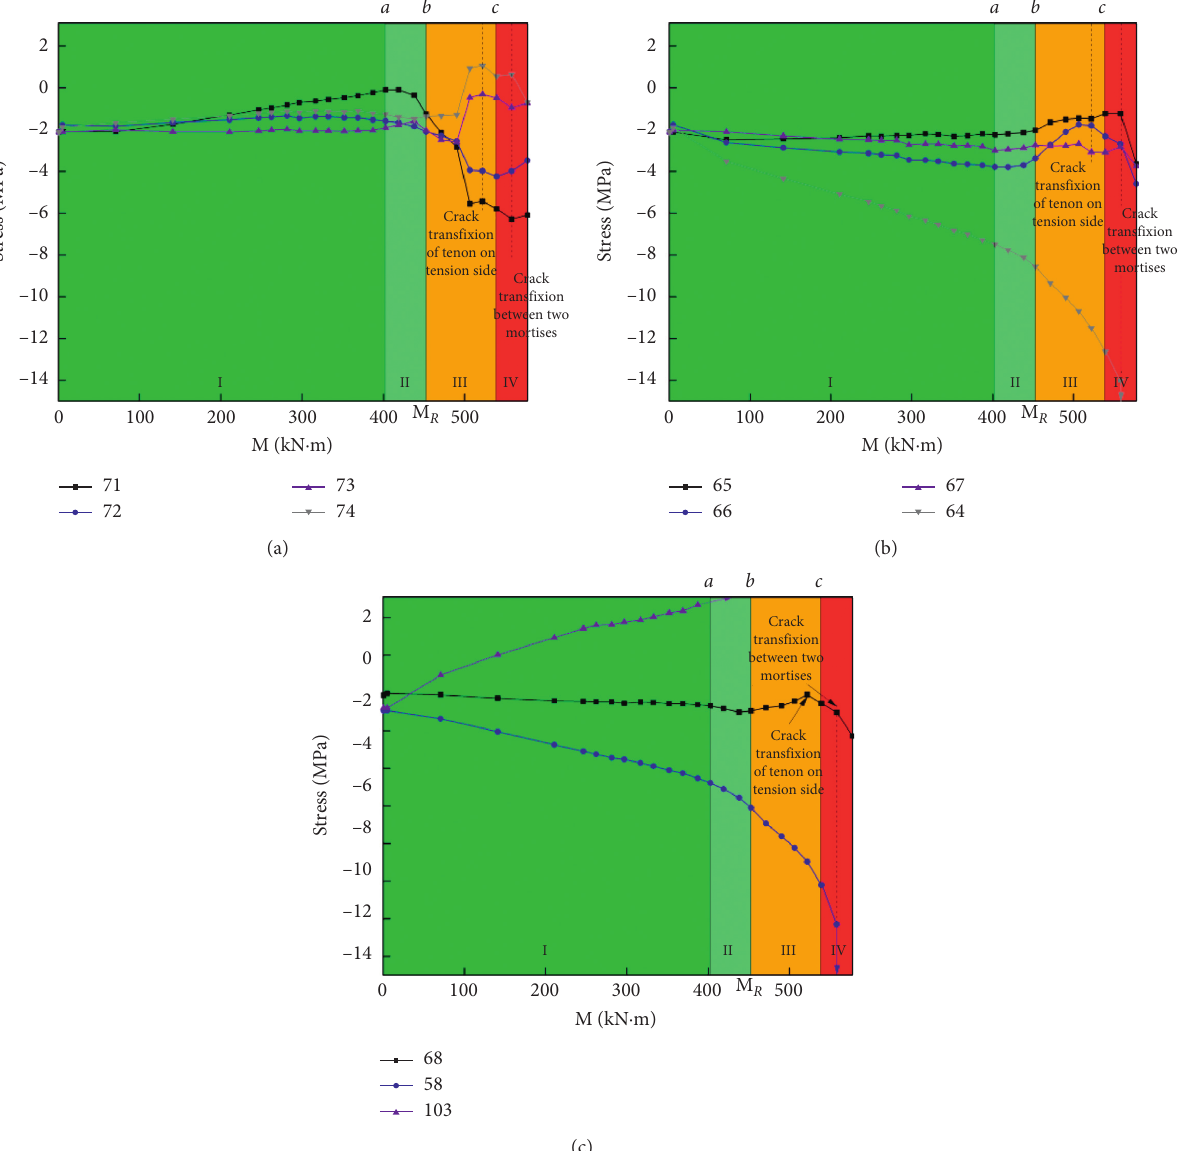
Figure 11: Change curve in stress with bending